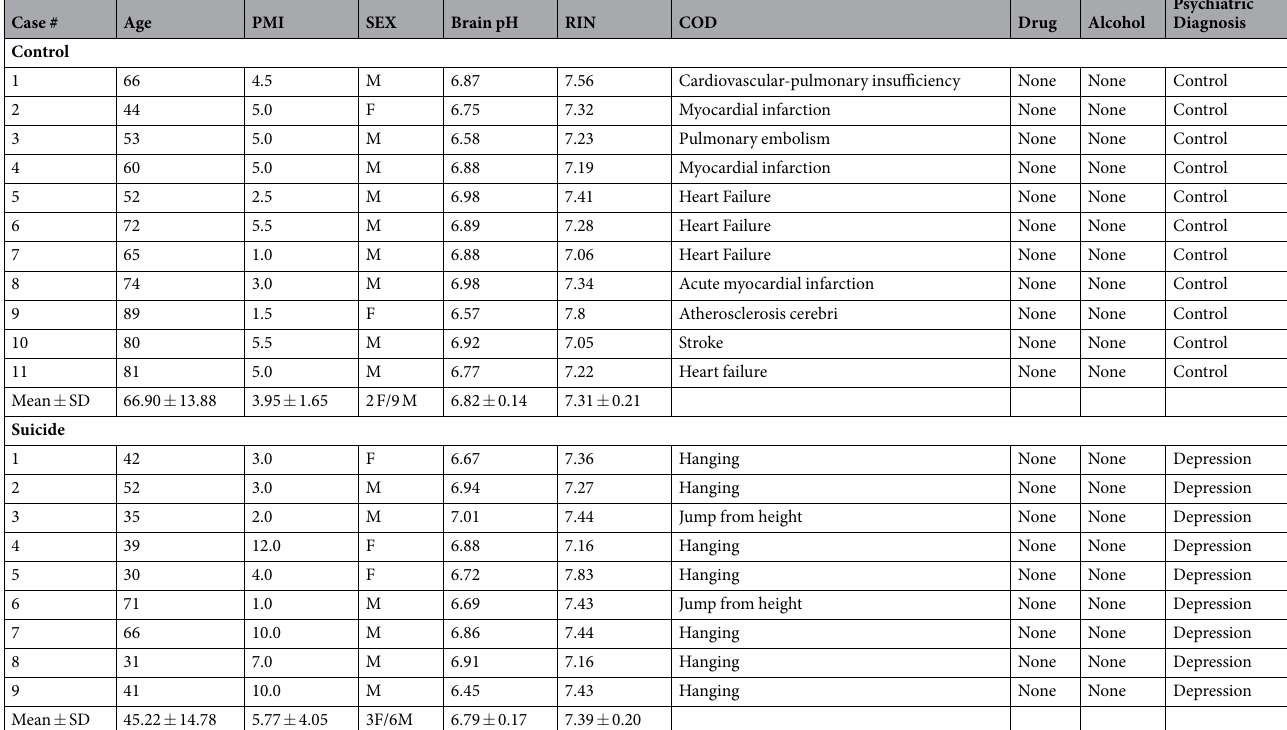
Table 1. Demographic and clinical characteristics of non-psychiatric controls and suicide